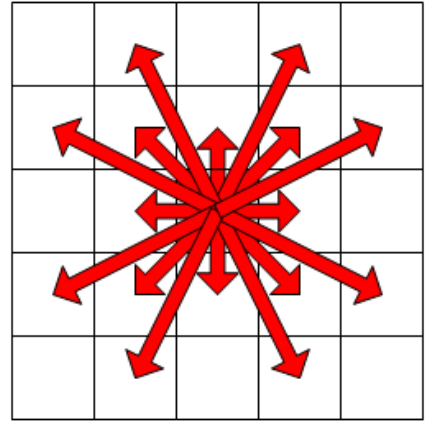
5 search range. Figure 3. 5 ∗ 5 search range. The 5 ∗ 5 search range artificial potential field method was added to the selection of ∗ 5 search range. sampling points, as shown in Figure 4. ∗